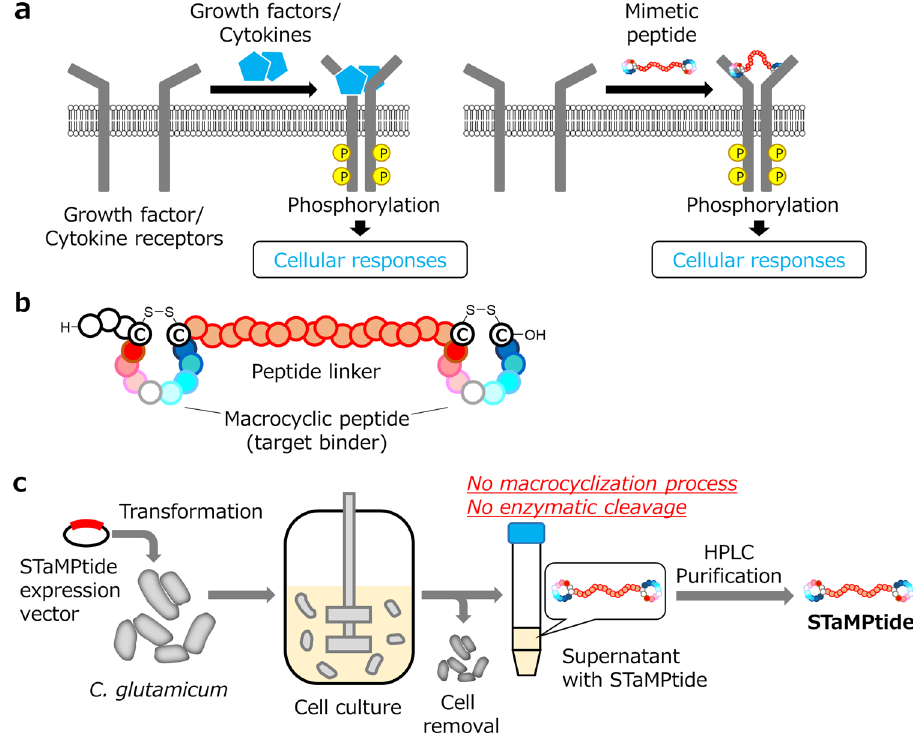
Fig. 1 Overview of the research. a Activation mechanism of cytokine and growth factor receptors by their ligands. Growth factors, cytokines, and their mimetics bind to their receptors to form heterocomplexes. Cellular signals are evoked by autophosphorylation of the receptors. b Structure of single-chain tandem macrocyclic peptides (STaMPtides), which include multiple disul fi de-closed macrocyclic peptide binders linked by peptide linkers. c STaMPtide production. STaMPtides are secreted by transformed Corynebacterium glutamicum into a supernatant and puri fi ed by decellularization and conventional